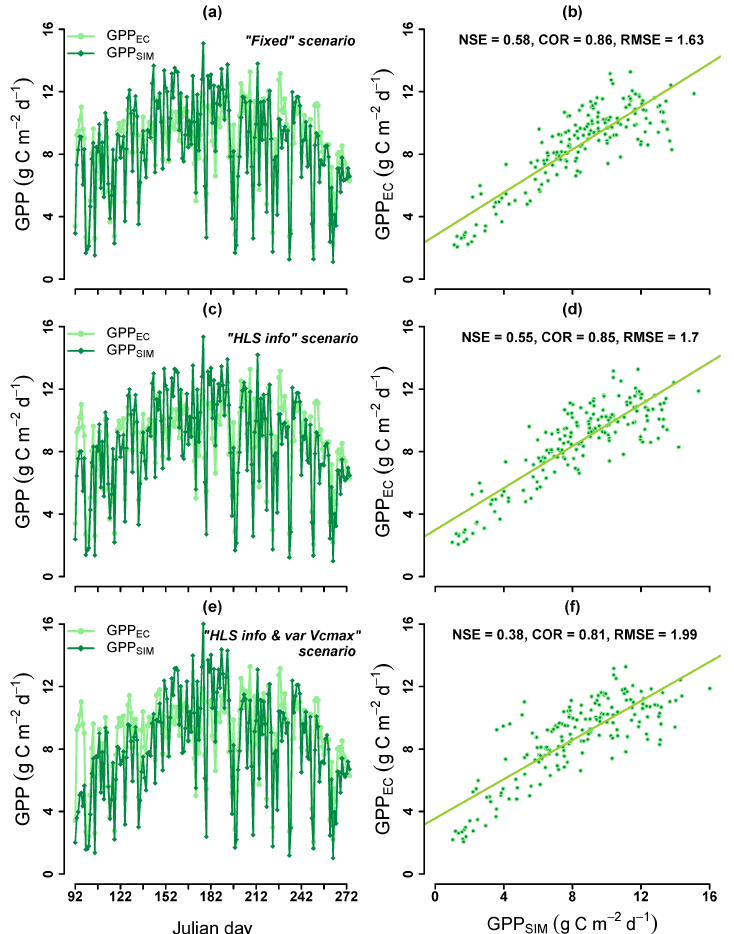
Figure 5. Left panels show the daily sum of flux-tower-measured (GPP EC ) and SCOPE-simulated (GPP SIM ) gross primary production for three scenarios: ( a,b ) Fixed scenario, ( c,d ) HLS info scenario, and ( e,f ) HLS info & var Vcmax scenario (detailed in Section 3.3) during the 2016 vegetation growing season. The right panels show the corresponding scatterplots between daily GPP EC and GPP SIM with the statistical evaluations. NSE: Nash–Sutcliffe efficiency, COR: correlation coefficient, RMSE: root mean square error, in g Cm − 2 s − 1